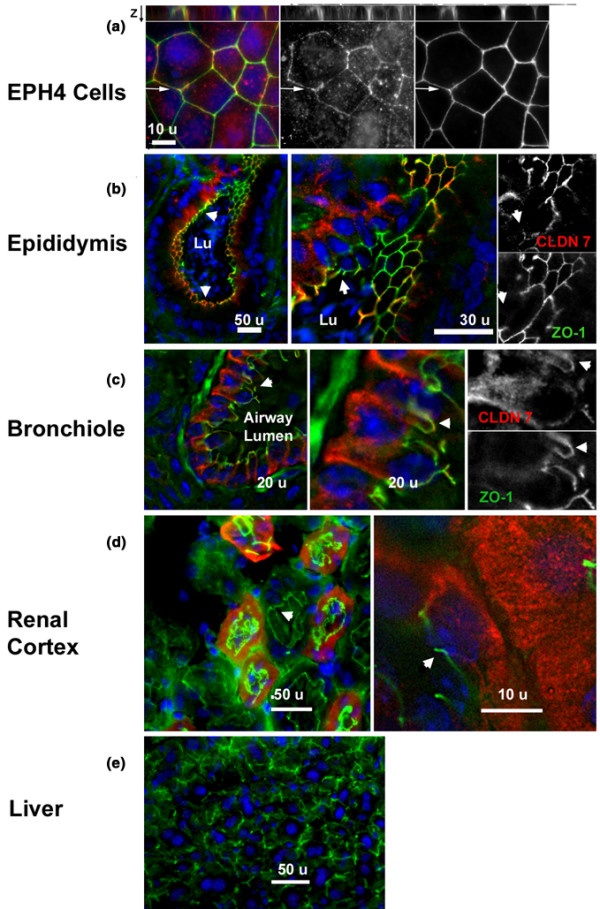
Immunolocalization of claudin 7 (Cy3, red) in cultured mammary epithelial cells, epididymis, lung, kidney, and liver. ZO-1 is stained with fluorescein isothiocyanate to demonstrate location of the tight junctions. (a) Eph4 cells. Claudin 7 is found with a patchy distribution at the tight junctions with ZO1. Vesicular stain can also be seen in the cytoplasm. The inset at the top shows the z axis across the xy view of the section at the level of the arrow. The overlap of ZO1 and claudin indicates colocalization at the level of resolution of the light microscope. (b) Mouse epididymis. Claudin 7 stain colocalizes with ZO-1 in most, but not all, tight junctions. Lu, lumen. Small arrowheads in this and subsequent panels denote the apical border of the epithelium. (c) Lung. The luminal cells of the bronchiole show heavy staining for claudin 7 in a punctate distribution at the basolateral surface of the cell; however, some claudin 7 colocalizes with ZO-1 (see black-and-white inset). (d) Kidney. Some of the tubules of the renal cortex stain as observed by Li and colleagues [7]. Claudin 7 shows a punctate distribution that is heaviest in the basal portion of the cells. (e) Liver. Tight junctions at the bile canaliculi are stained with ZO-1. However, no stain for claudin 7 is apparent. The magnification for each figure is indicated by the label (u, μm) above the scale bar.